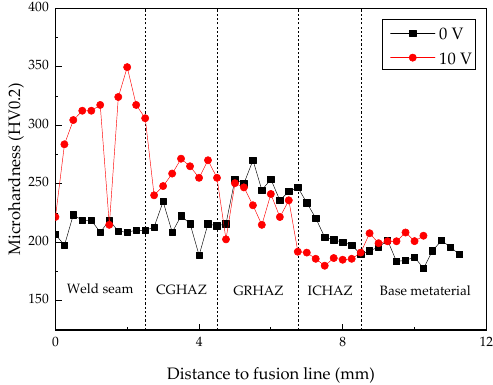
Figure 5. Microhardness distribution of the weld joints.